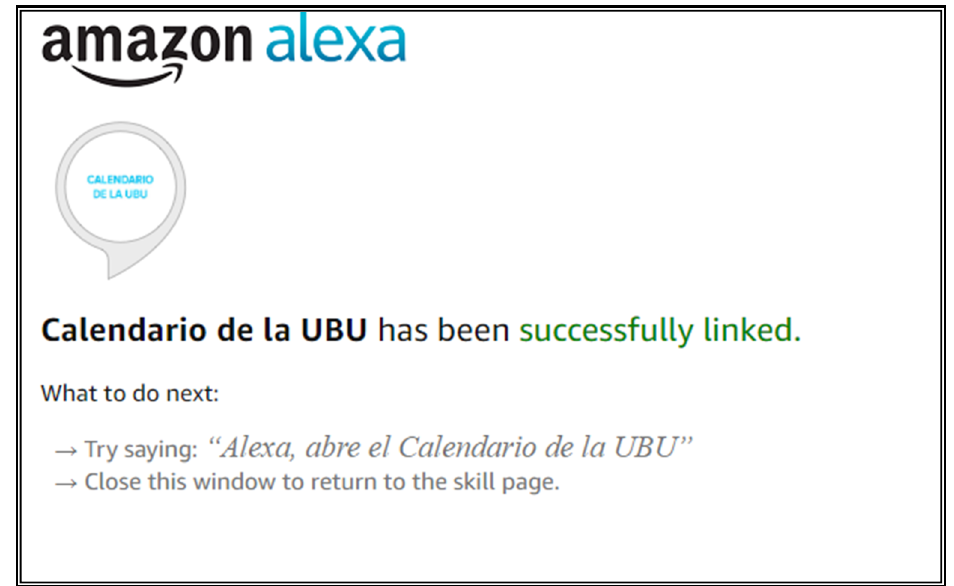
Figure 1. Intelligent personal assistant (IPA). Skill Alexa “UBUVoiceAssistant”.